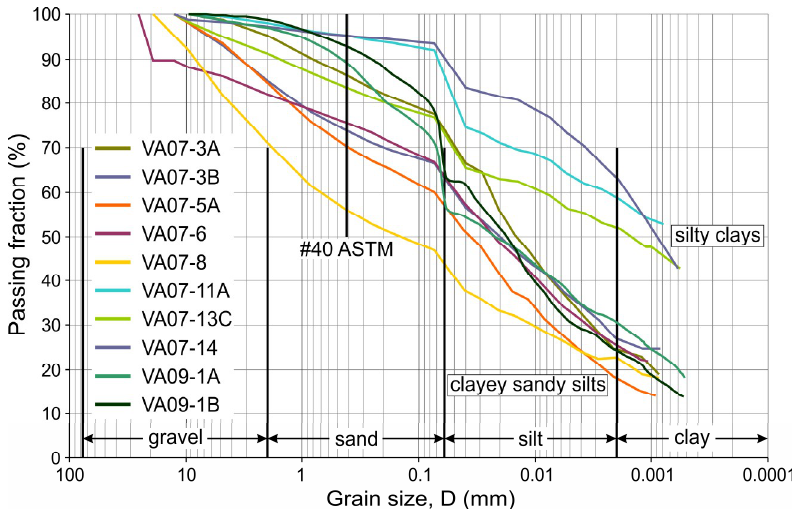
Figure 7. Grain-size distribution curves of soil samples collected from the basal shear zone of the Vajont slide.